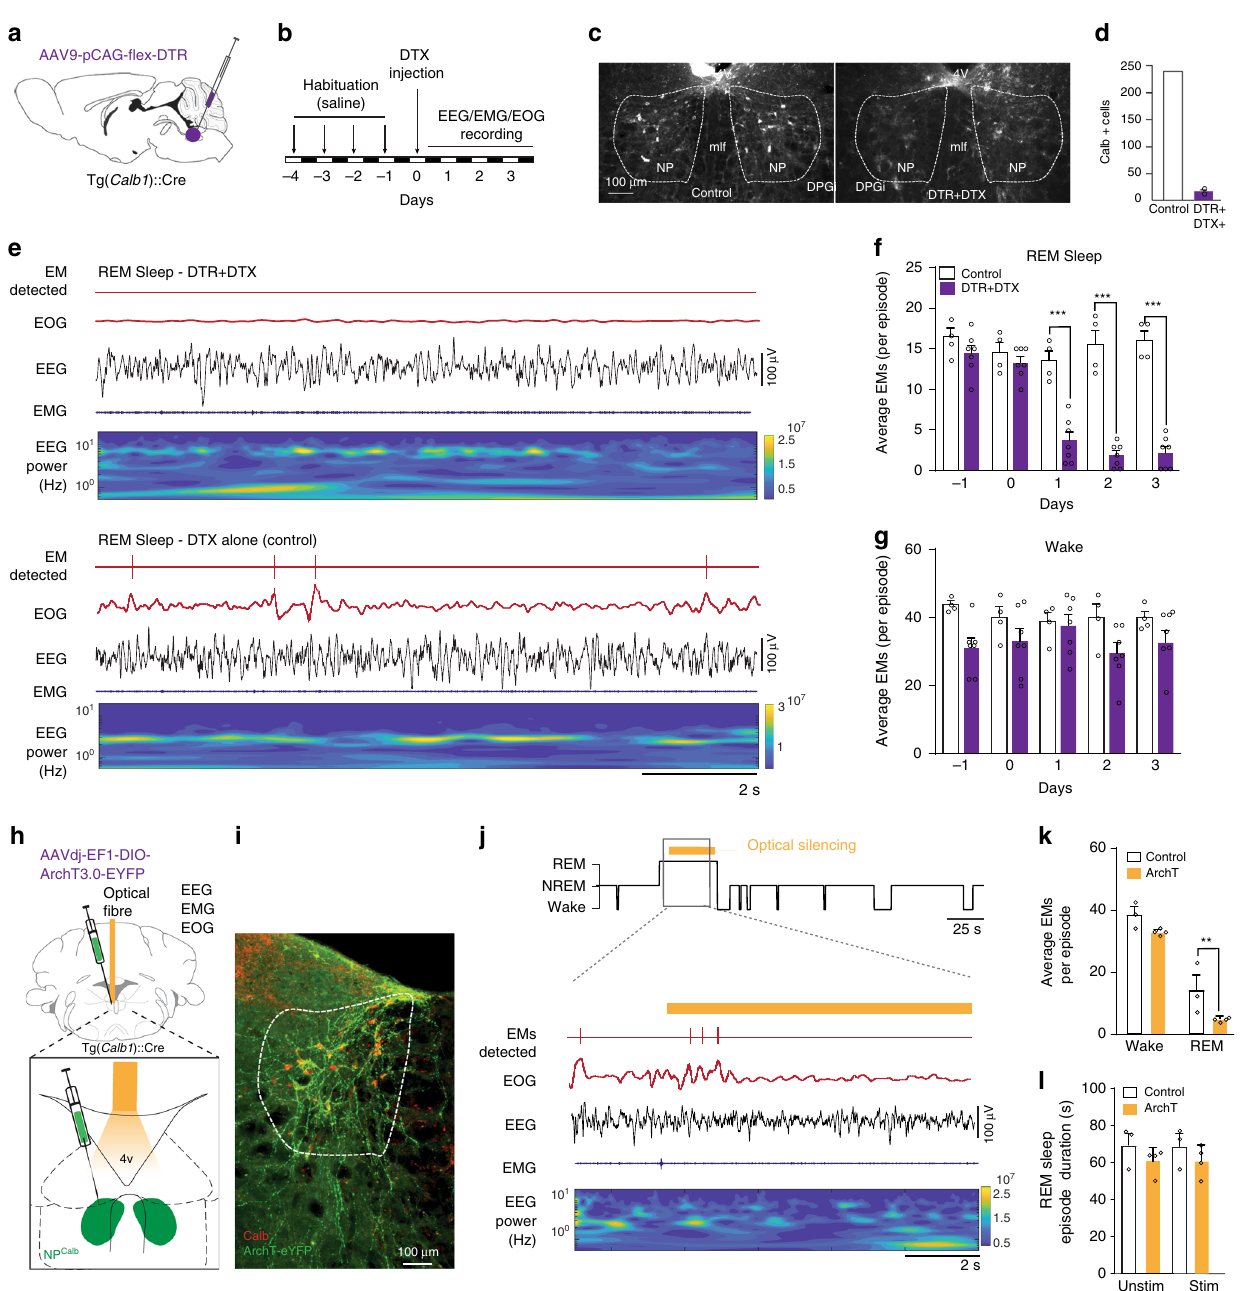
Fig. 5 Genetic ablation and optogenetic silencing of NP Calb neurons block EMs during REM sleep but not wakefulness. a Schematic representation of the genetic targeting of the diphtheria toxin receptor (DTR) expression to NP Calb neurons and implantation of optical fi bre. b Experimental timeline. c Representative micrographs depicting immunoreactivity for Calb protein in a non-transduced (left) and a DTR-transduced (right) mouse, both i.p.-injected with diphtheria toxin (DTX). Note the remnants of disintegrating neurons in the extracellular space displaying some immunoreactivity for Calb (right). 4V: fourth ventricle; mlf: medial longitudinal fasciculus; NP: Nucleus papilio . d The number of Calb-expressing neurons is dramatically reduced upon DTX injection in DTR-transduced ( n = 3) as compared with a wild-type animal that received DTX alone. e Representative experiment showing detected EMs, EOG, EEG and EMG signals, and time frequency heat-map of EEG spectral power from animals transduced with DTR and injected with DTX (upper set of traces) and control mice injected with DTX alone (lower set of traces) during REM sleep. f , g Averaged number of EMs during REM sleep f and wakefulness g , before and after DTX injection ( n = 7 DTR + /DTX + and four control animals; Wakefulness: P = 0.523, F (4, 36) = 0.8171; REM sleep: P ≤ 0.001, f (4,36) = 19.2). *** P < 0.0001, two-way ANOVA followed by Sidak ’ s post hoc tests). Genetic ablation of NP Calb neurons does not signi fi cantly decrease the number of EMs during wakefulness but eradicate EMs during REM sleep. h Schematic representation of the genetic targeting of AAV2-Ef1a-DIO-ArchT3.0-EYFP inhibitory opsin expression to NP Calb neurons and implantation of optical fi bre. i Representative micrograph showing ArchT-YFP expression (green) in Calb- immunoreactive neurons (red). j Experimental strategy for optical silencing of NP Calb neurons selectively during REM sleep (top). Detected EMs, EOG, EEG and EMG traces and time frequency heat-map of EEG spectral power (bottom). Orange bar represents the duration of the optical silencing. k Averaged number of EMs during wakefulness and REM sleep in the control ( n = 3) and ArchT3.0 ( n = 4) transduced mice. **, P = 0.11, two-way-ANOVA followed by Sidak ’ s multiple comparison test. Error bars represent SEM values. l Duration of REM sleep episodes under conditions in which pulses of light were either not delivered (unstim.) or delivered (stim.) to silence the NP Calb neurons, in control and transduced mice. Error bars represent SEM